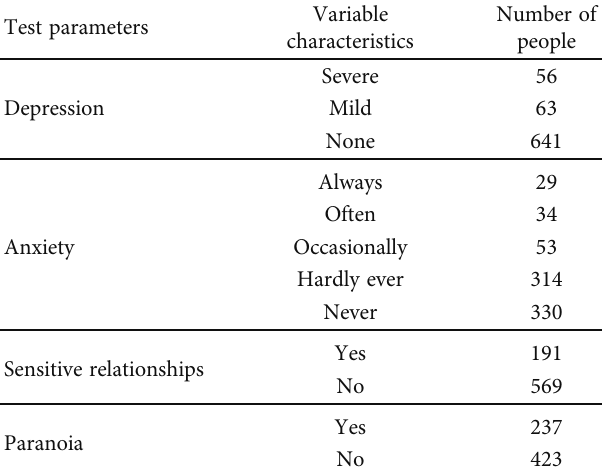
Table 3: Pre- and posttest comparisons of college students ’ mental health. Test